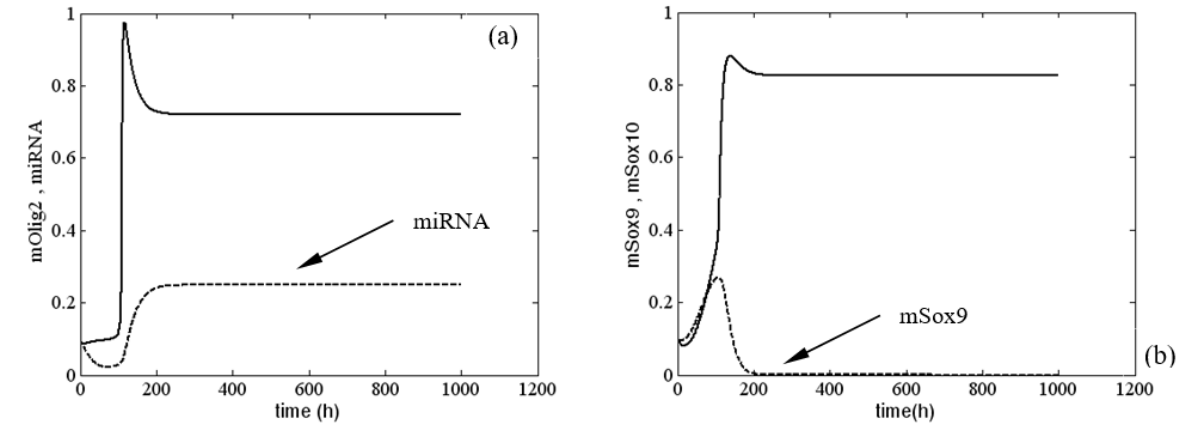
Figure 2. Time evolution of ( a ) mOlig 2 ( y 1 ) , miRNA ( y 4 ) ; ( b ) mSox 9 ( y 2 ) , mSox 10 ( y 3 ) at k 2 = 0.4762 and I 1 = I 2 = 0. Legend: ( a ) mOlig 2 —solid line; ( b ) mSox 10 —solid line. All other parameter values are as those in (5).